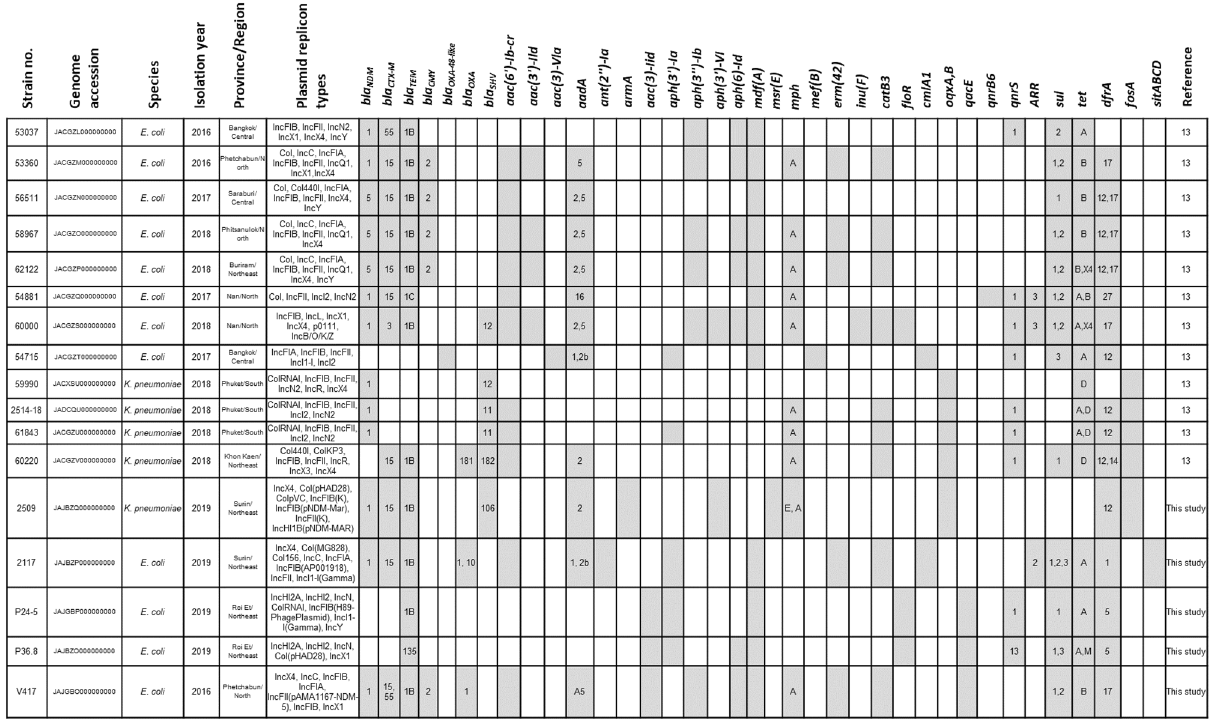
Table 1. Distribution of sequence types and antimicrobial-resistant genes in mcr-1 -carrying E. coli and K. pneumoniae